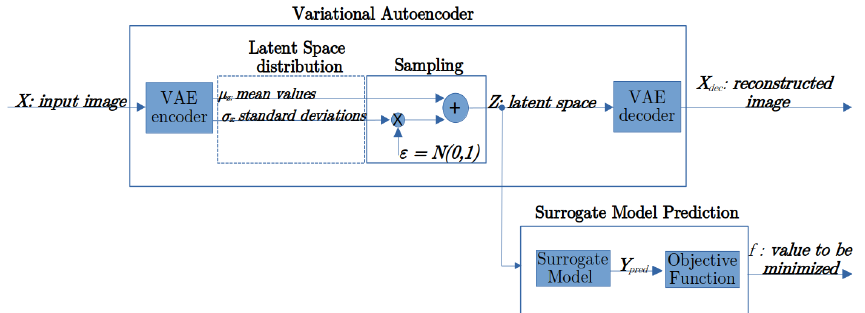
Figure 1. Main elements of the DL